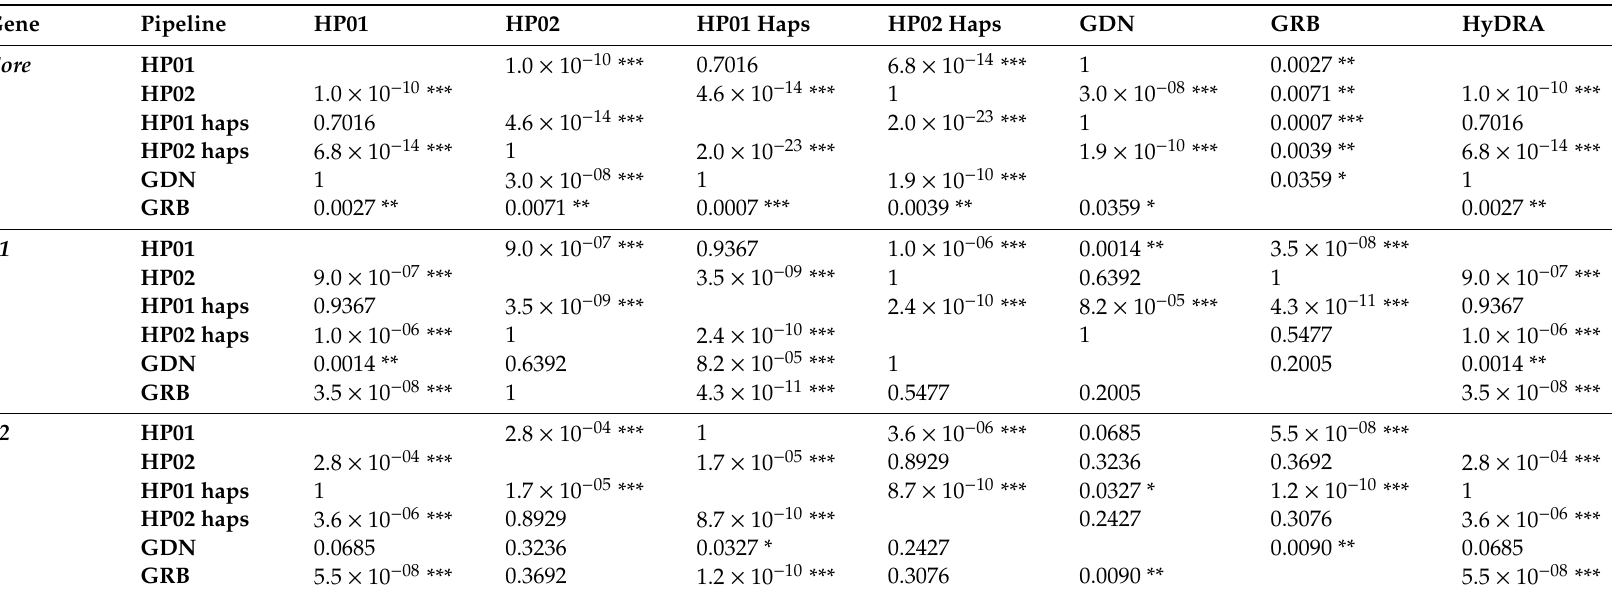
Table A8. Kruskal–Wallis multiple comparisons (Dunn test) of the adjusted genetic p-distance of the pipeline consensus sequence from H77, the HCV reference sequence, for the HCV empirical dataset. Adjusted p-values are reported (Holm